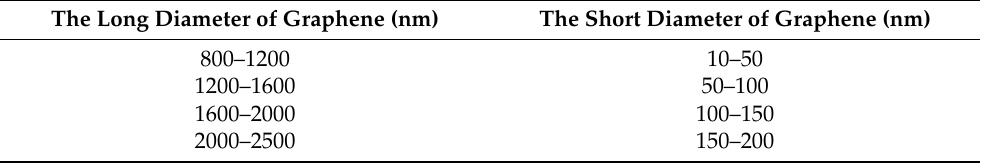
Table 2. The characteristic size of